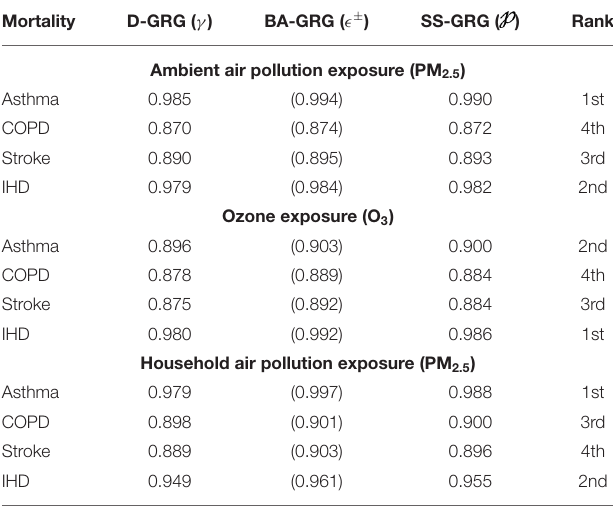
TABLE 1 | Grey incidence assessment between mortality and associated factors. Mortality